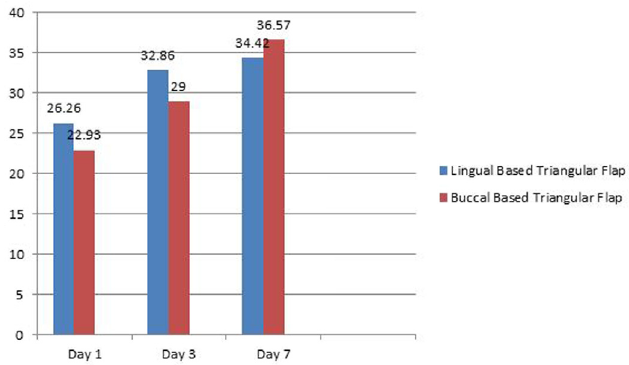
Fig. 8. The average scores for mouth opening (mm) between buccal based triangular fl ap and lingual based triangular fl